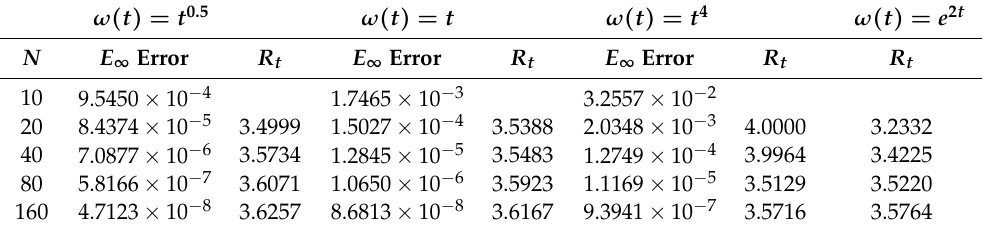
Table 4. E ∞ errors and convergence rates R t for Example 1, when ζ ( t ) = t , α = 1 weight